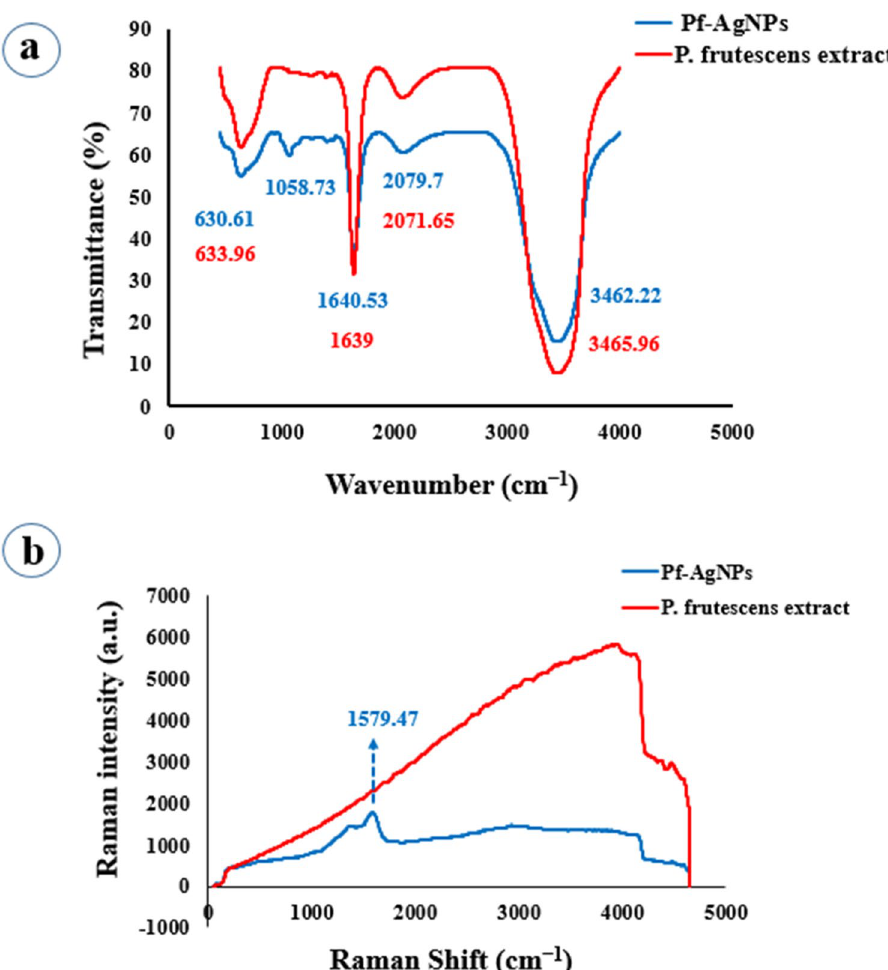
Figure 3. FTIR spectrum of the extract of Perilla frutescens and Pf-AgNPs ( a ), and Raman spectrum of the extract of Perilla frutescens and Pf-AgNPs ( b